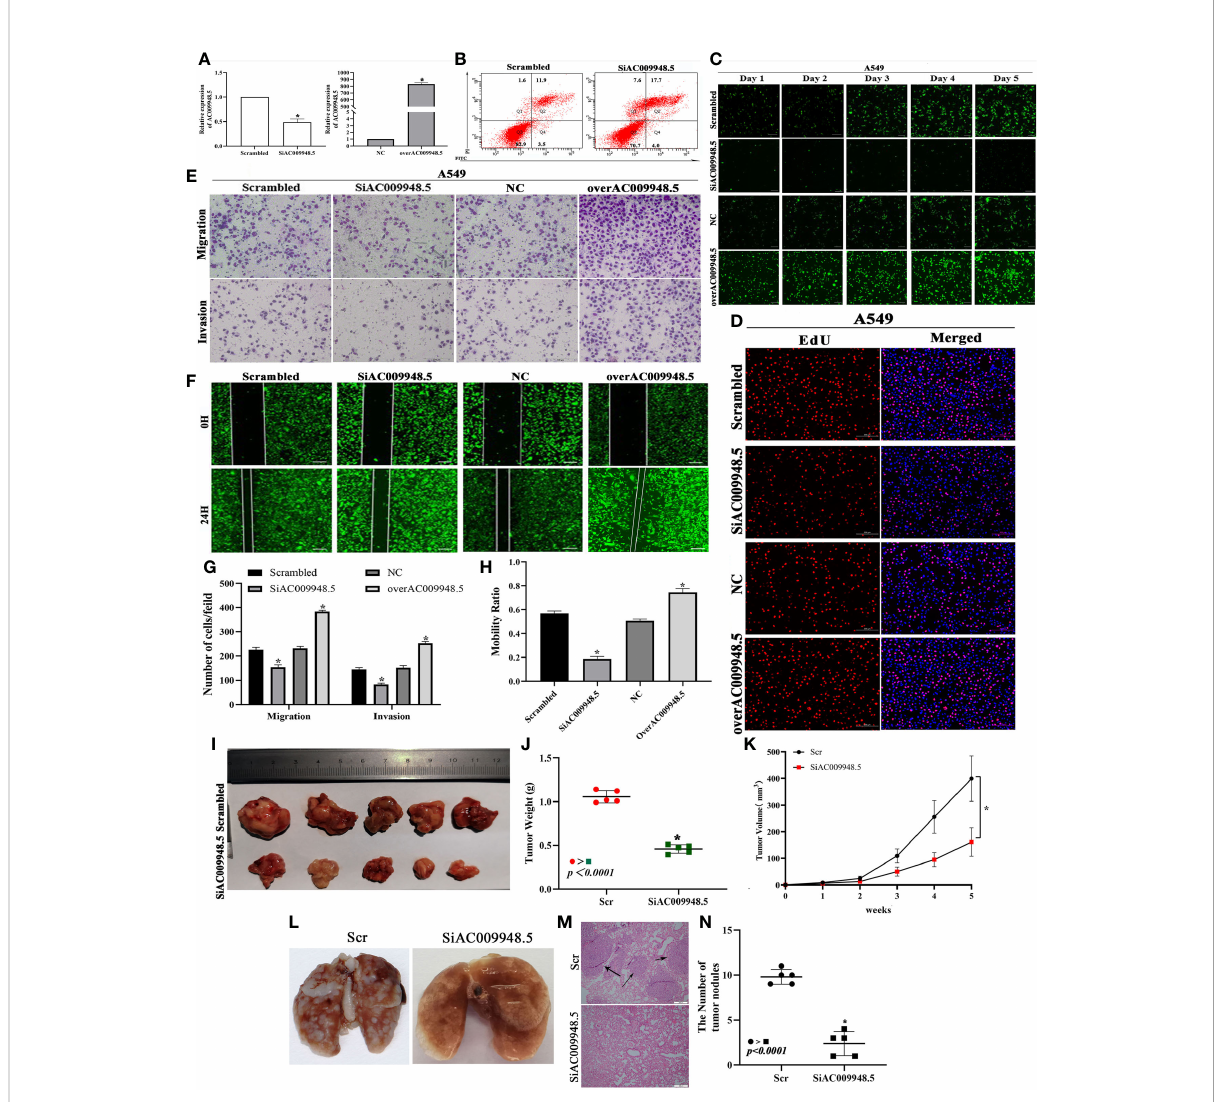
FIGURE 2 Effects of LncRNA-AC009948.5 on lung adenocarcinoma cells apoptosis, proliferation, and metastasis in vitro and in vivo . (A) Expression of LncRNA-AC009948.5 after infection of A549 cells detected by qRT-PCR. (B) Flow cytometric analysis of infected A549 cells. (C) Cell proliferation ability detected by Celigo system. (D) Cell proliferation ability detected by EdU staining. (E) The migration and invasion ability of the cells in each group were detected by Transwell assay, and the cells were counted and analyzed. The results are presented in the number of each fold. Scale bar: 100 m m. (F) Cell mobility ability was detected by wound healing assay, and the cells were counted and analyzed. The results are presented in percentages. Scale bar: 200 m m. Data are represented as mean ± S.D. * P <0.05. The results were repeated three times independently. (G, H) Migration and invasion assays for transfected cells. (I, J) The weight and image of tumors excised from xenograft models. (K) Tumor growth curve. *P<0.05 vs. Scr . (L) Representative pictures of pulmonary metastatic nodules of mice after injection. (M) H&E staining showed pulmonary sections with metastatic nodules (scale bar: 200 m m). (N) Scatter plot was used to count the number of lung metastases